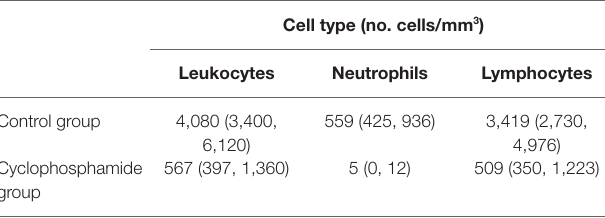
TABLE 2 | Leukocyte, neutrophil, and lymphocyte concentrations in the blood of ddY mice following administration of cyclophosphamide. Cell type (no. cells/mm 3